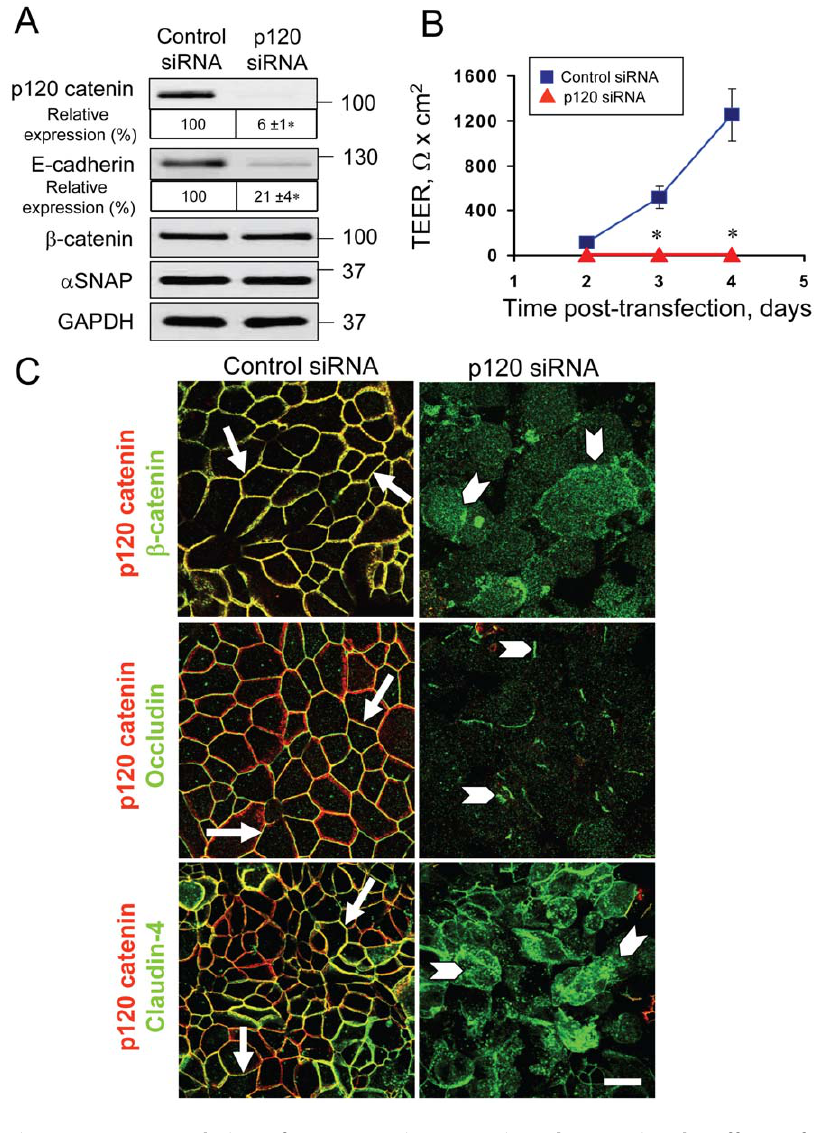
Figure 5. Downregulation of p120 catenin expression phenocopies the effects of a SNAP depletion on epithelial junctions. ( A ) Immunoblotting analysis shows that p120 catenin-specific siRNA dramatically decreases p120-catenin and E-cadherin protein expression in SK-CO15 cells. ( B ) TEER measurements demonstrate that p120 catenin-depleted SK-CO15 cell monolayers do not develop the paracellular barrier on days 2–4 post-transfection. ( C ) Immunofluorescence labeling shows formation of normal b -catenin-based AJs and occludin/claudin-4-based TJs (arrows) in control SK-CO15 cell monolayers. In contrast, p120 catenin-depleted cells display a defective AJ/TJ assembly and intracellular localization of junctional proteins (arrowheads) on day 4 post-transfection; *p , 0.01 compared to the control siRNA-treated group (n=4). Scale bar, 20 m